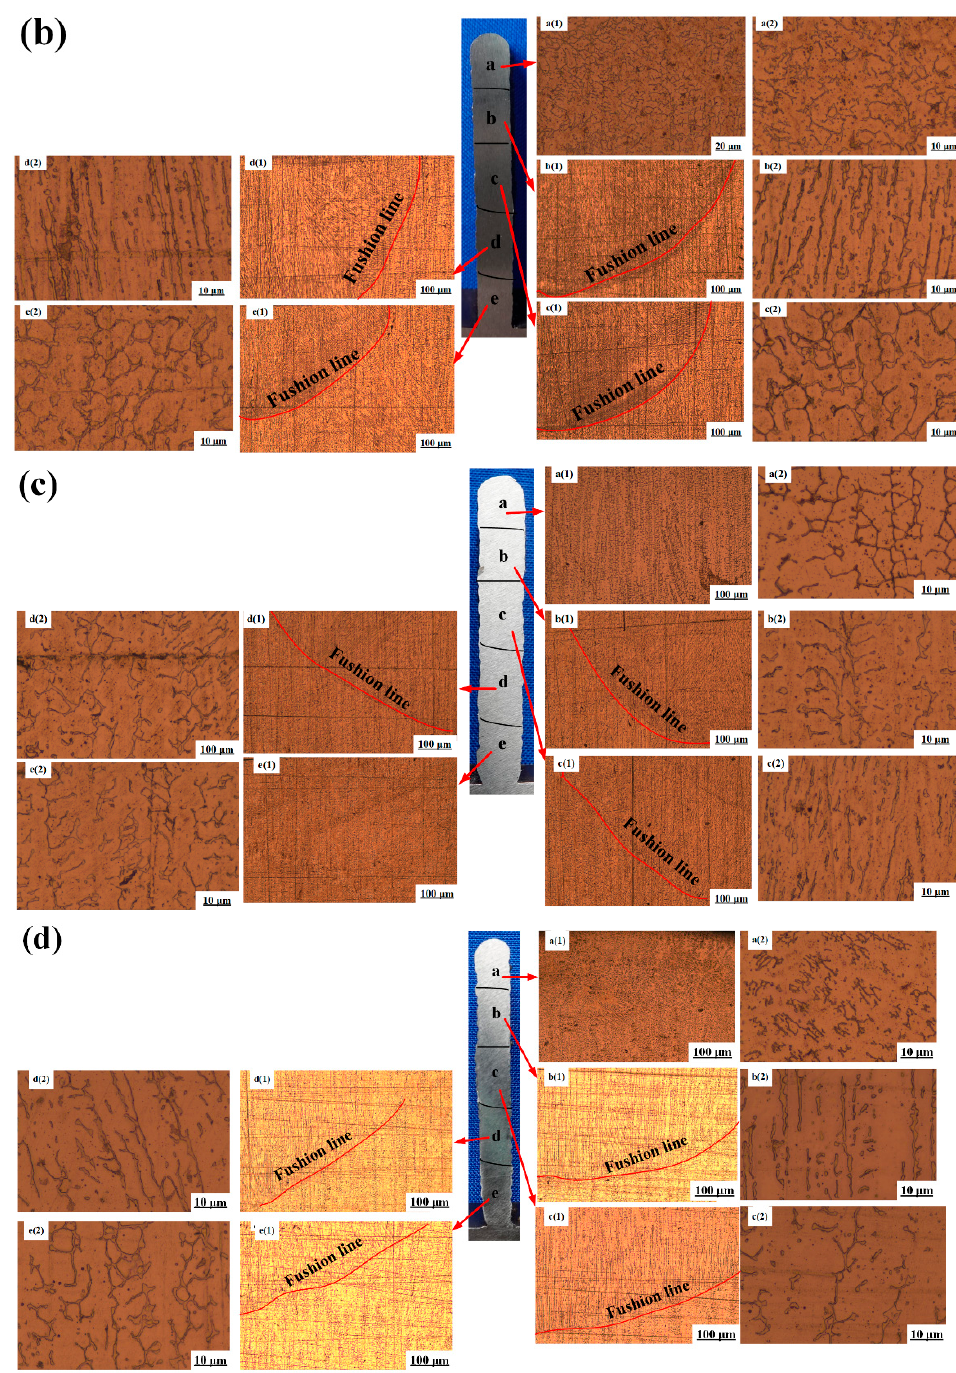
Figure 9. Microstructure of different layers of specimens: ( a ) specimen A, ( b ) specimen B, ( c ) speci- men C, ( d ) specimen D. ( a1 , a2 ) layers 41–50, ( b1 , b2 ) layers 31–40, ( c1 , c2 ) layers 21–30, ( d1 , d2 ) lay- ers 11–20, ( e1 , e2 ) layers